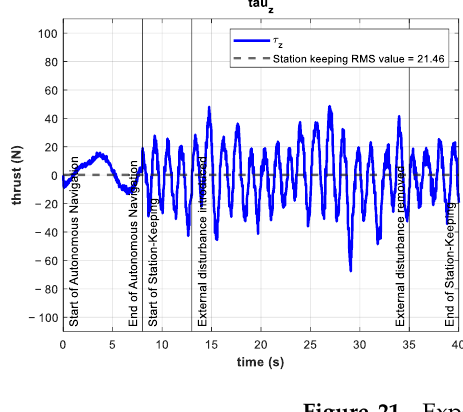
introduced in the interval 13 s ≤ 𝑡 ≤ 25 s . Control signal 𝜏 𝑧 ( left ) and thruster coefficients 𝑢 5 , 𝑢 6